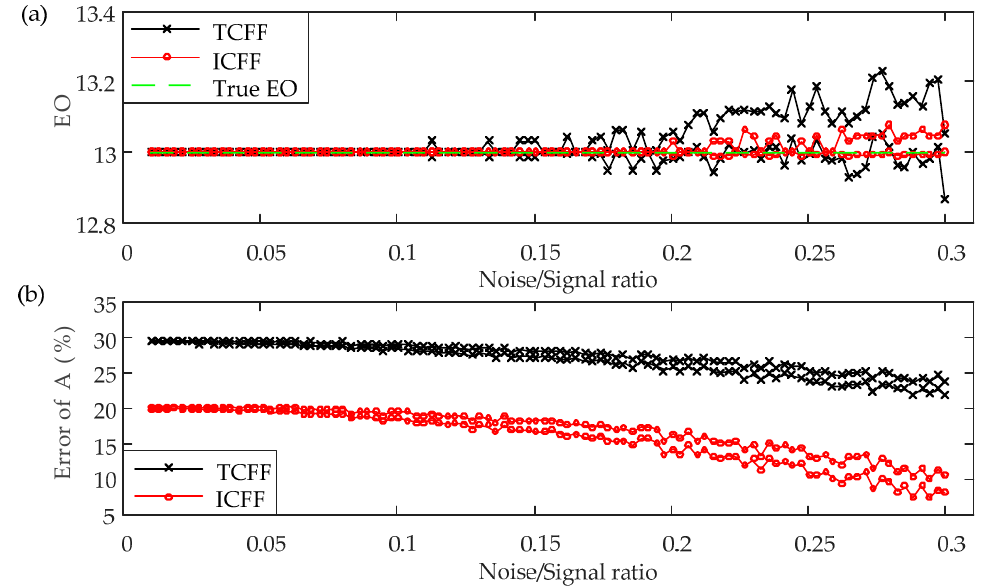
Figure 8. Results of Test 4. ( a ) 95% confidence intervals of the EO identification and ( b ) 95% confidence intervals of the relative error of the amplitude identification.